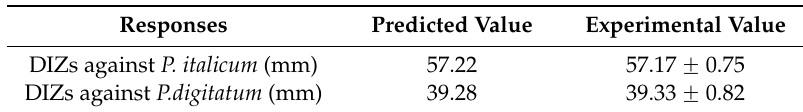
Table 4. Response values under optimal conditions of ethanol concentration (90%), extraction time (65 min), solvent to solid ratio (31 mL/g) and temperature (51 ˝ C).